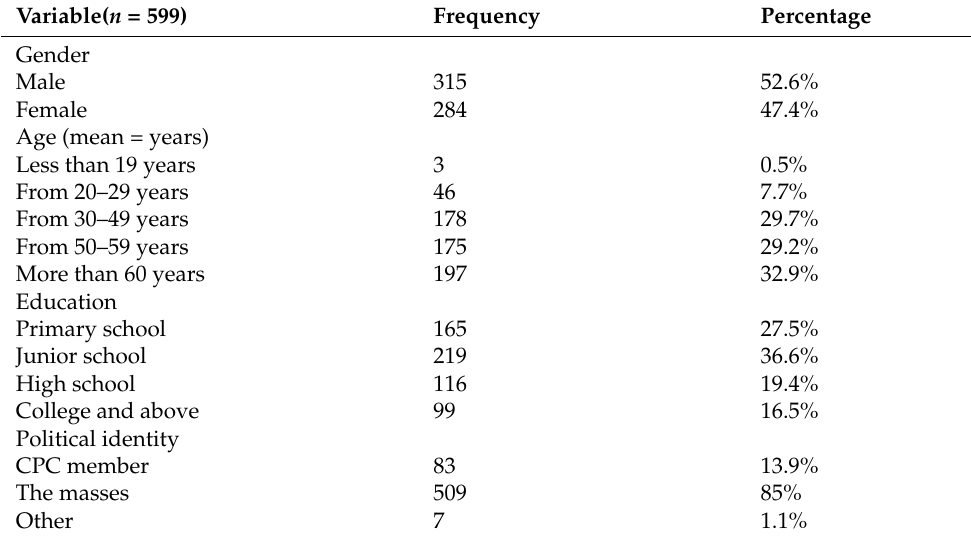
Table 3. Descriptive statistics for the